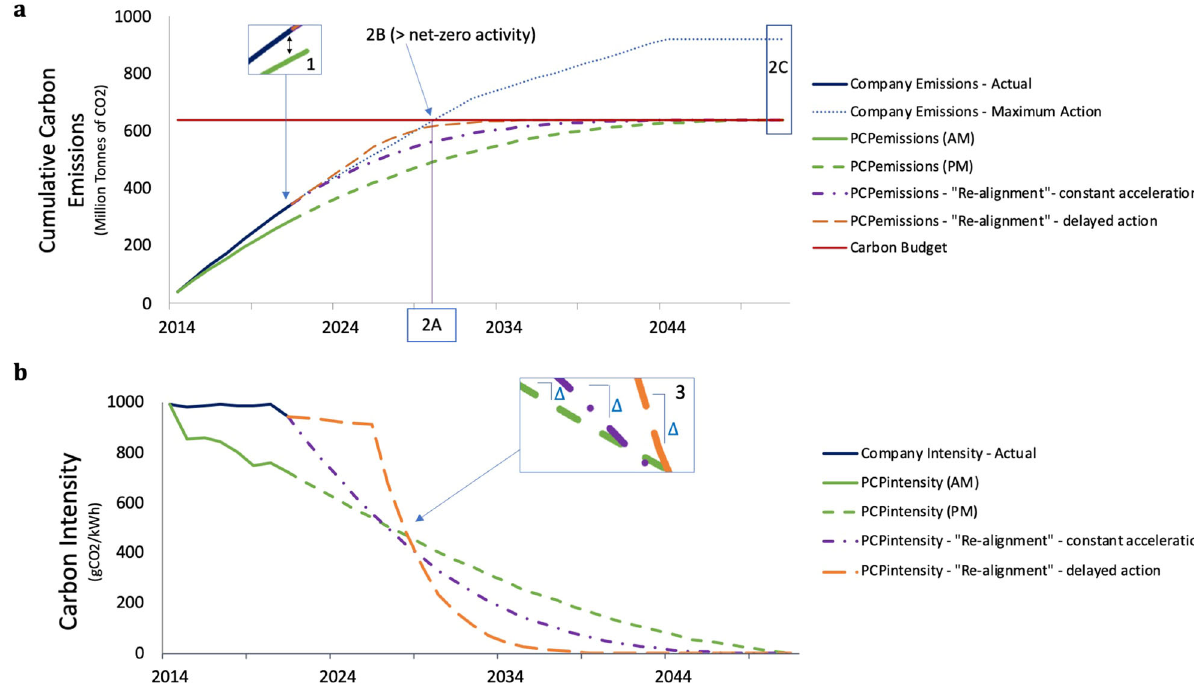
Fig. 2 Paris Compliant Pathways and transition performance metrics for the largest Australian electric utility company (AGL). Both Panel a and Panel b show the same Paris Compliant Pathway (PCP) using the Sectoral Decarbonisation Approach on an existing company ’ s initial intensity (2014) and actual market share (green line) and projected market share (dashed green line), where Panel a shows carbon intensities and Panel b shows cumulative carbon emissions. It also shows two possible “ re-alignment ” PCP ’ s the company could follow to stay within its carbon budget: a PCP featuring a constant “ accelerated ” decarbonisation rate which commences immediately (dotted yellow line); and a PCP which follows recent (2014 – 2021) decarbonisation rates for the next 5 years, followed by a new accelerated decarbonisation rate (long-dashed orange line). Panel a shows Metric 1 and metric 2. Metric 1 measures the performance since the base year (cumulative emissions since the base year 2014 relative to the Climate-safe Emissions Pathway). Metric 2 is composed of three sub-metrics; 2A is the estimated year that the company carbon budget will be fully emitted based on a “ maximum action ” scenario of future cumulative emission projections, all assuming constant market-share (short dash). A “ maximum action ” scenario is based on the company ’ s most recently announced closure dates for fossil fuel generating assets and assumes the replacement of such assets with zero-emissions generation capacity and their market share being kept constant; 2B is the amount of activity in place under the “ maximum action ” scenario at the EYF with a positive emission intensity; 2C is the emissions under the “ maximum action ” scenario in 2050 compared to the carbon budget. Panel b also illustrates Metric 3